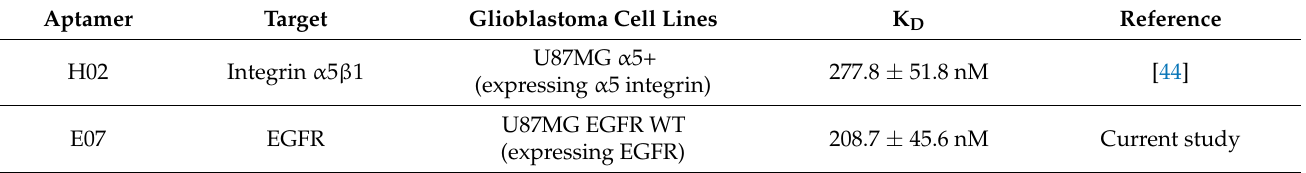
Table 1. Affinity (K D ) of the interaction between aptamers and cells, determined using flow cytometry. Aptamer Target Glioblastoma Cell